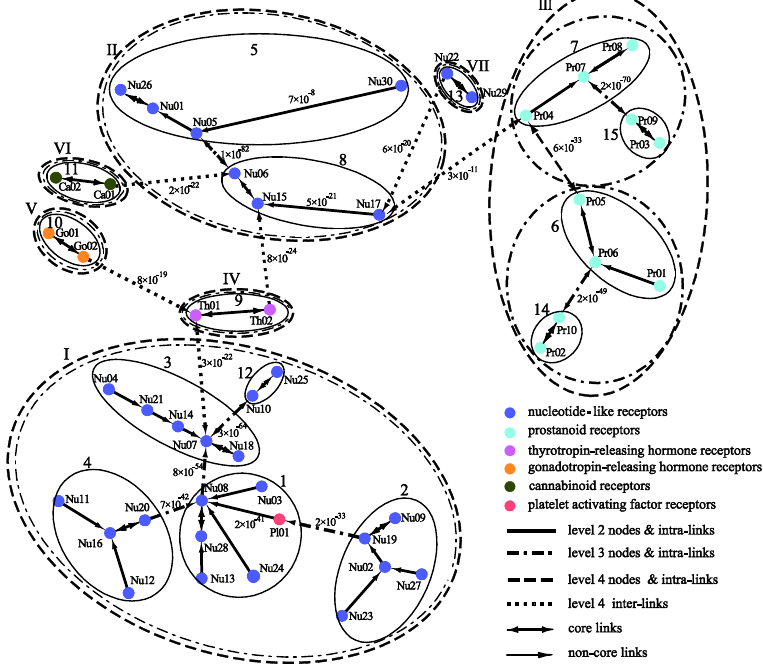
Figure 5. A distance-based phylogenetic tree of the GPCR network, as constructed by MSClustering. The clustering structure of the network is shown for MSC levels 2–4. Each node, colored according to GPCRdb’s classification, is a level 1 MSC cluster. Numerical edge labels show the smallest E values between clusters.